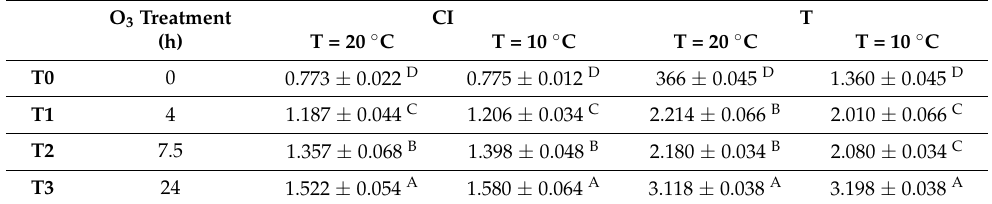
Table 2. Color intensity (CI) and tonality (T) of red mute Lambrusco must treated with O 3 gas (8 µ L L − 1 ) for the indicated time of treatment, at 20 and 10 ◦ C. Data are the mean of three glass jars, each temperature ( ± SE) in two replicated experiments. In the column for each parameter, different capital letters indicate significance at p < 0.01.